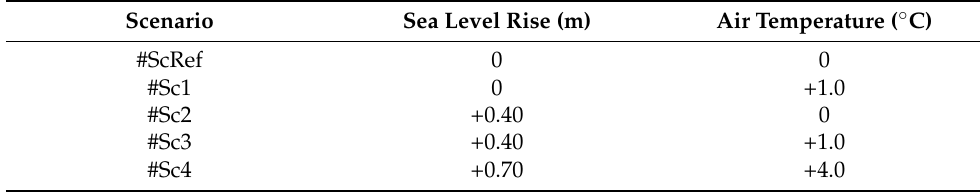
Table 4. Idealized scenarios used in the model simulations.